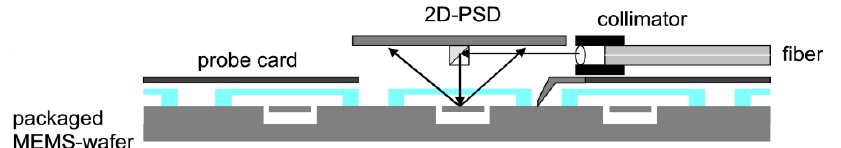
Figure 8. Schematic of the optical measurement setup used for wafer level